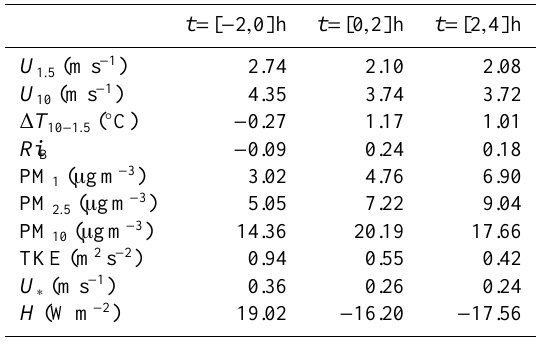
Figure 2. Observed 10–1.5m temperature di ff erence evolution for di ff erent types of evening transitions (A, B, C). Times are normal- ized around sunset for each day ( t sunset = 0h).